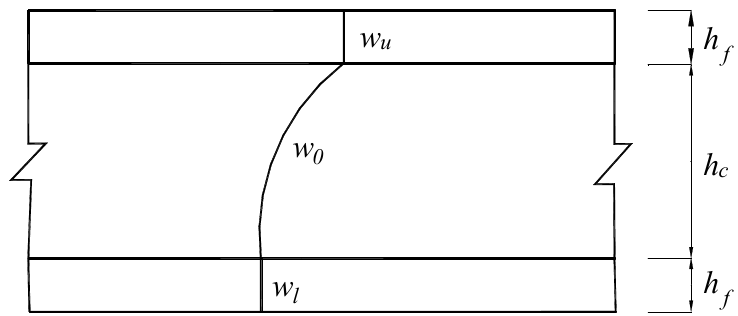
Figure 2. In-plane displacement fields in laminas.